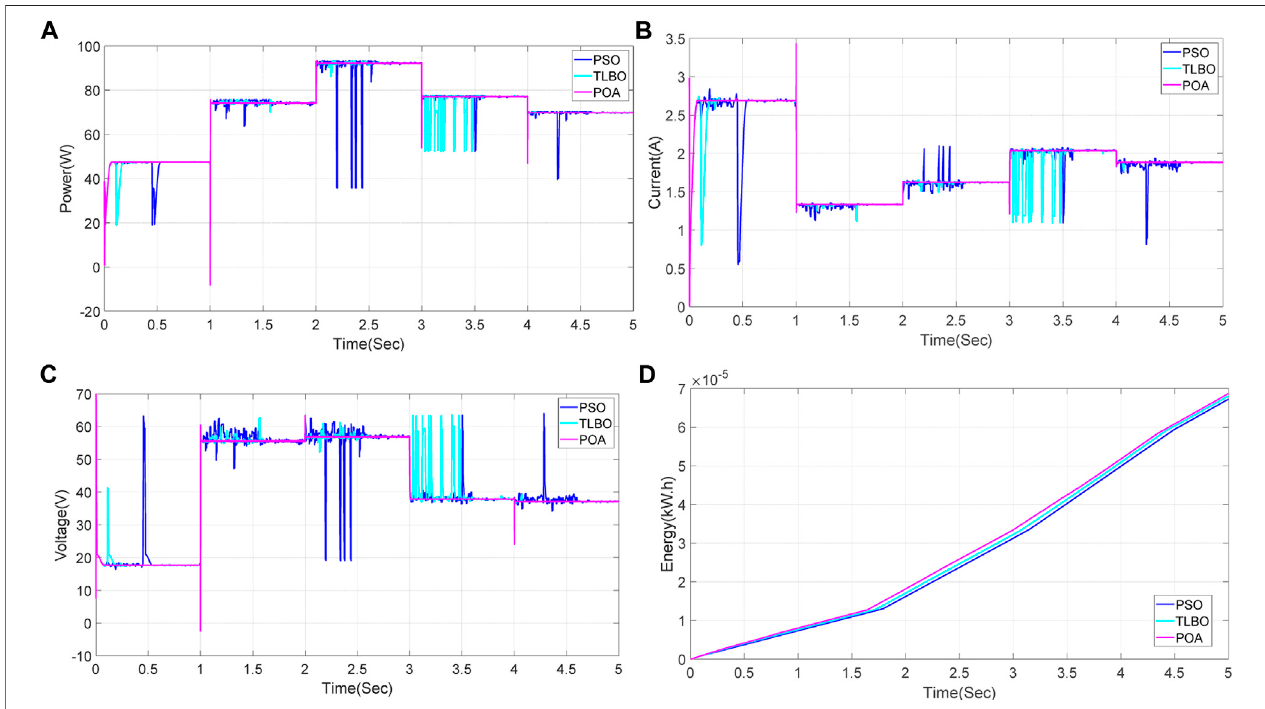
FIGURE 6 | PV system responses of three techniques obtained on the step change in solar irradiation with constant temperature. (A) Current, (B) Voltage, (C) Power, and (D) Energy.